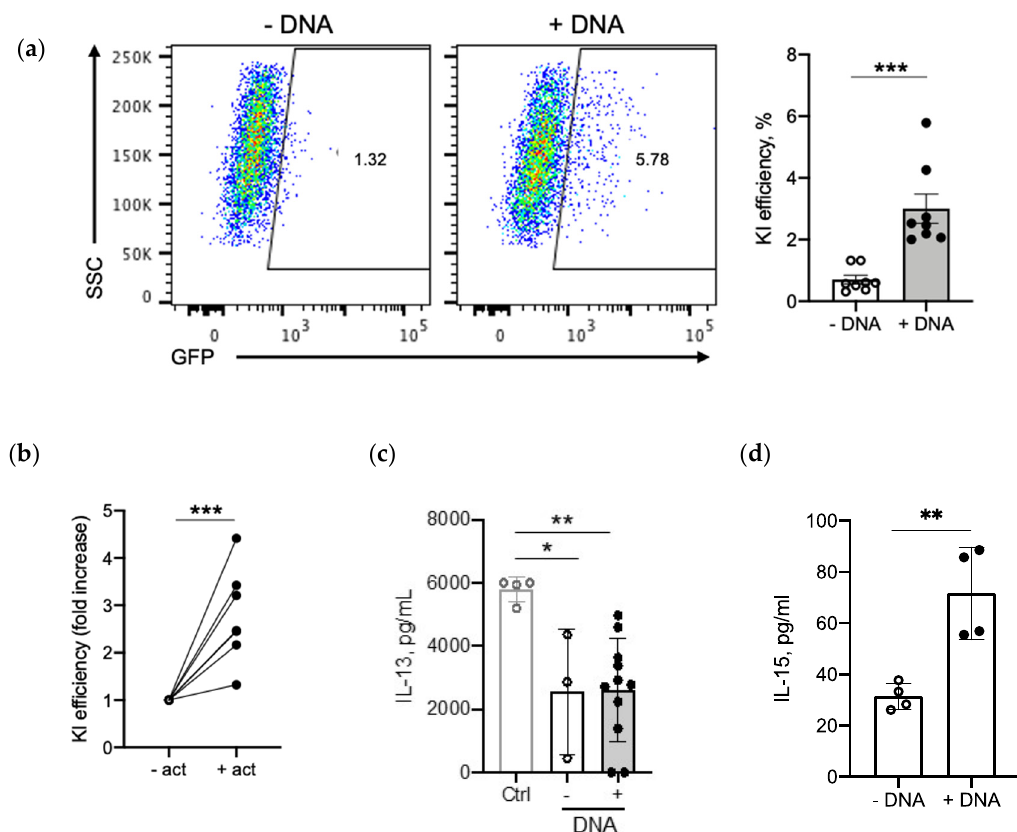
Figure 6. IL-15.E2A.mClover3 knock-in into IL-13 locus: ( a ) Transgene expression was evaluated by flow cytometry of GFP+ T cells 10 days post-electroporation; left panel, representative flow plots (samples electroporated without template DNA (-DNA) served as controls); right panel, summary graph of left panel ( n = 8, two-tailed t -test; *** p = 0.0004). ( b ) Fold increase of knock-in efficiency without (-) or with (+) T-cell activation ( n = 6, two-tailed t -test, *** p = 0.0005) ( c ) Knock-out of IL-13 was confirmed by IL-13 secretion; Ctrl, control knock-out; -DNA, knock-in without DNA template; +DNA, knock-in with DNA template ( n = 3–11, one-way ANOVA, * p = 0.036 ** p = 0.007). ( d ) IL-15 expression from IL-13-edited (10 days post-electroporation) T cells 24 h post-T-cell activation ( n = 4, two-tailed t -test, ** p = 0.005).